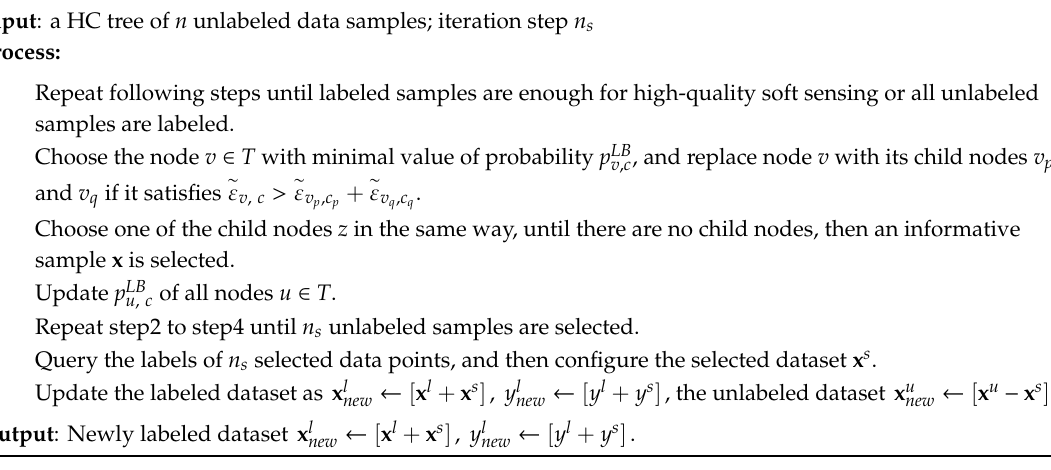
Figure 3. Flow diagram of HC process and different pruning results. Algorithm 1 : The proposed hierarchical sampling strategy under AL framework